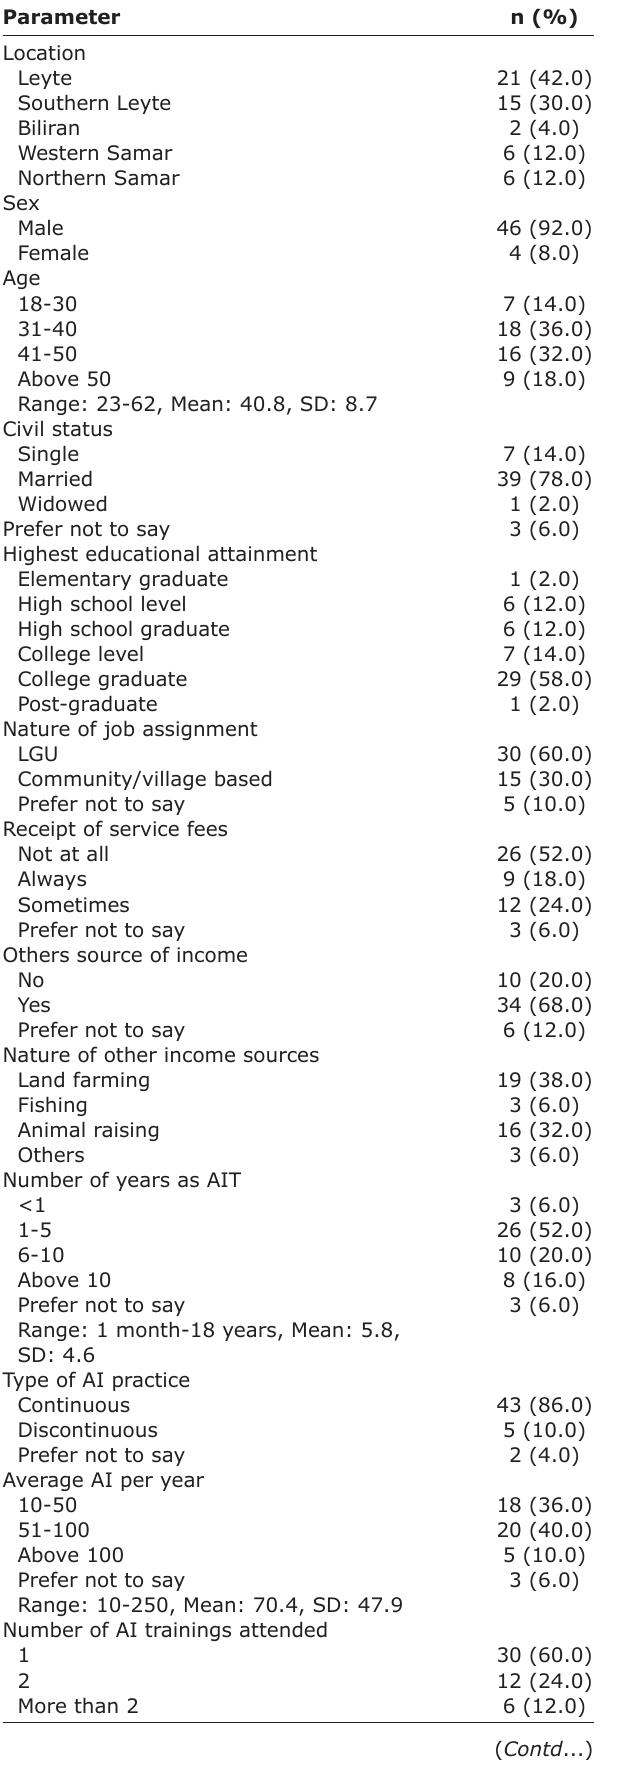
Table-1: Profile of AITs in Eastern Visayas (n=50).